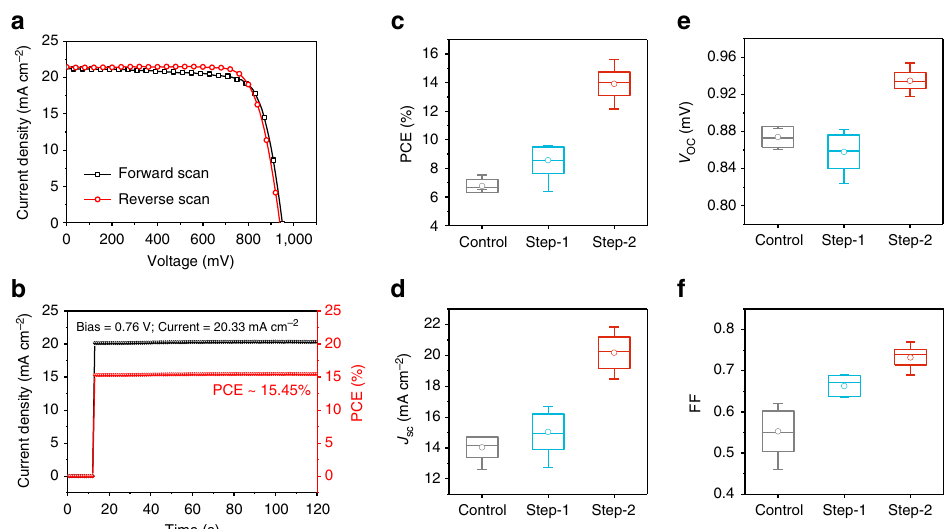
Figure 5 | Performance of the champion device and distributions of device photovoltaic parameters. ( a ) J–V curves of the champion device using NH 4 Cl-containing precursor and moisture-induced crystallization process measured by reverse scan (RS) and forward scan (FS) with a scan rate of 100mVs (cid:3) 1 . RS: V OC ¼ 0.94V, J SC ¼ 21.45mAcm (cid:3) 2 , FF ¼ 0.77, PCE ¼ 15.60%; FS: V OC ¼ 0.95V, J SC ¼ 21.20mAcm (cid:3) 2 , FF ¼ 0.75, PCE ¼ 15.17%. ( b ) Stabilized output of the device measured under a bias of 0.76V, presenting a current density of 20.33mAcm (cid:3) 2 and a PCE of 15.45%. ( c – f ) Histograms of PCE, J SC , V OC and FF of devices fabricated using conventional drop-casting method with precursor of PbI 2 and CH 3 NH 3 I in DMF (control), and moisture- induced crystallization method (step-1 for thermal annealing, step-2 for ambient exposure) with precursor of PbI 2 , CH 3 NH 3 I and NH 4 Cl in DMF. The data are represented as a standard box plot where the box range, median line and circle dot are defined by the s.d., middle value and average value. The whiskers represent the outlier values with a coefficient of 1.5. The results are summarized from 30 devices.